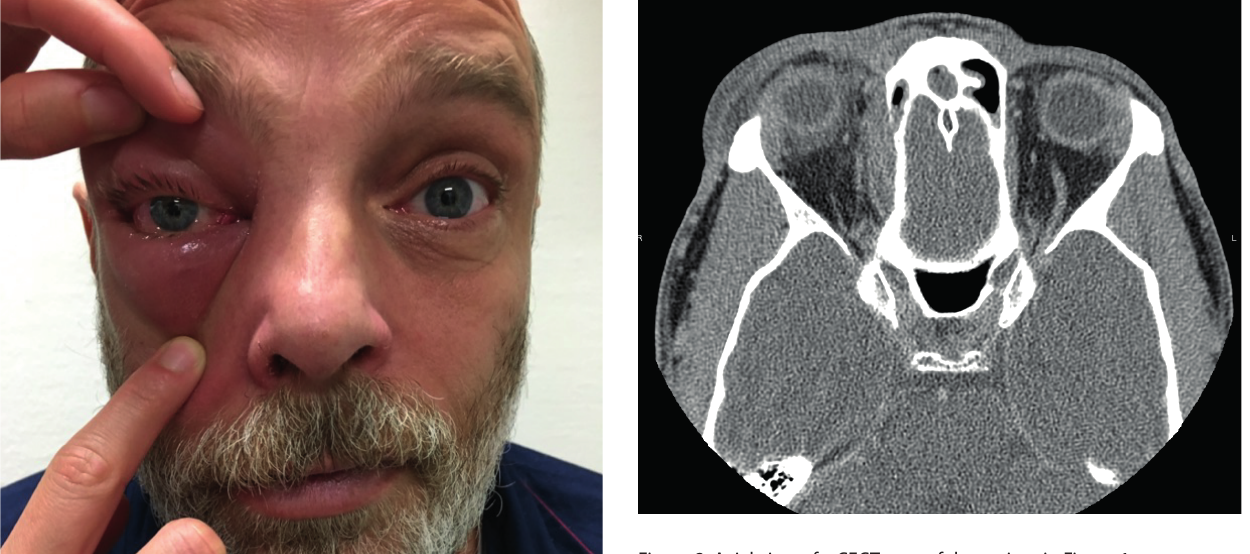
Figure 2. Axial view of a CECT scan of the patient in Figure